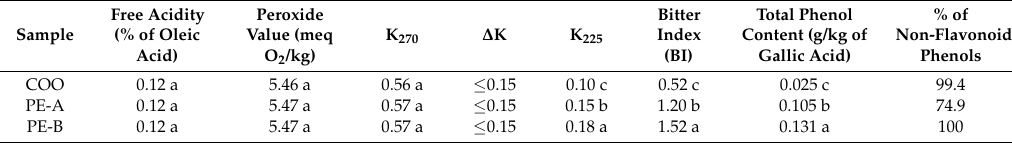
Table 3. Quality parameters and total phenol content of control oil and phenol-enriched